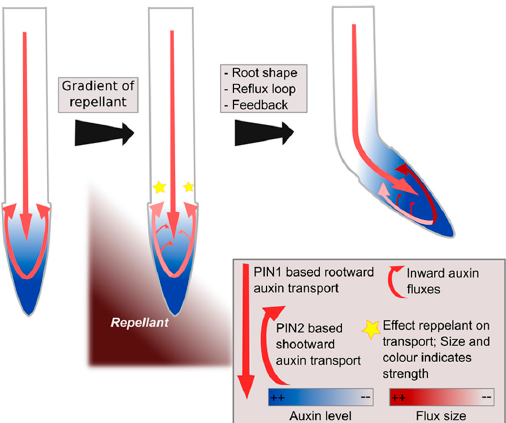
Figure 3. Hypothetical model of left–right sensing in plants during tropisms. A gradient of repellent, for example diffusing NaCl, causes a stress response at both sides of the root, though somewhat stronger at one side than the other, causing modulations in the reflux loop ( middle panel ). Subsequent positive feedback of auxin on its own transporters combined with root tip architecture and reflux loop properties amplify initial differences into a clear instructive auxin asymmetry, enabling bending [49] ( right panel ).